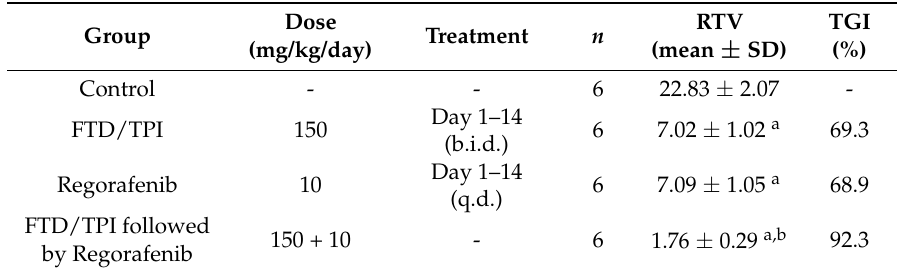
Table 2. Anti-tumor effects of trifluridine/tipiracil (FTD/TPI) and regorafenib in mice implanted with COLO205 human colorectal tumors.